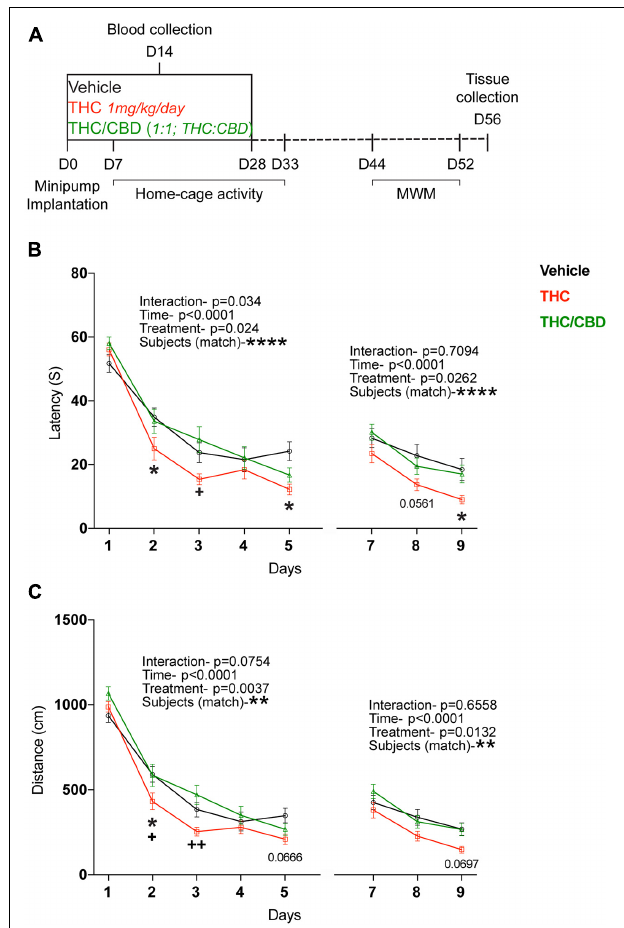
FIGURE 1 | Effect of THC and THC/CBD on spatial learning in old mice. (A) Scheme depicting the experimental paradigm. (B) Spatial learning was assessed in the acquisition and reversal phases of the Morris water maze (MWM) test. Spatial learning performance was significantly improved in THC-group compared to vehicle- and THC/CBD-groups. (C) Spatial navigation ability tested during the acquisition and reversal phases of the MWM test. THC significantly improved the spatial navigation ability in old mice compared to vehicle- and THC/CBD-groups ( n = 21–25 mice per group). Data represented as mean ± SEM, ∗ p < 0.05 (difference between vehicle- and THC- treatment groups); + p < 0.05, ++ p < 0.005 (difference between THC-and THC/CBD-treatment groups); ** p < 0.01; **** p < 0.0001 variation between the subjects; p -values stated are the differences between THC- and vehicle- treated groups; 2-way ANOVA (repeated measures) with Tukey’s multiple comparison